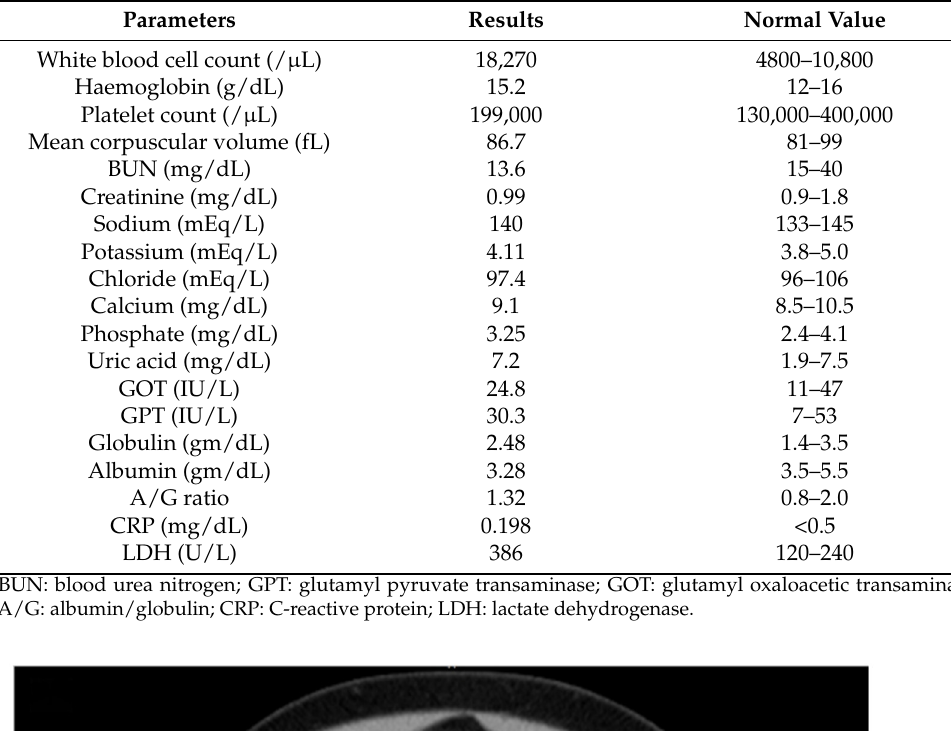
Table 1. Blood biochemistry data.